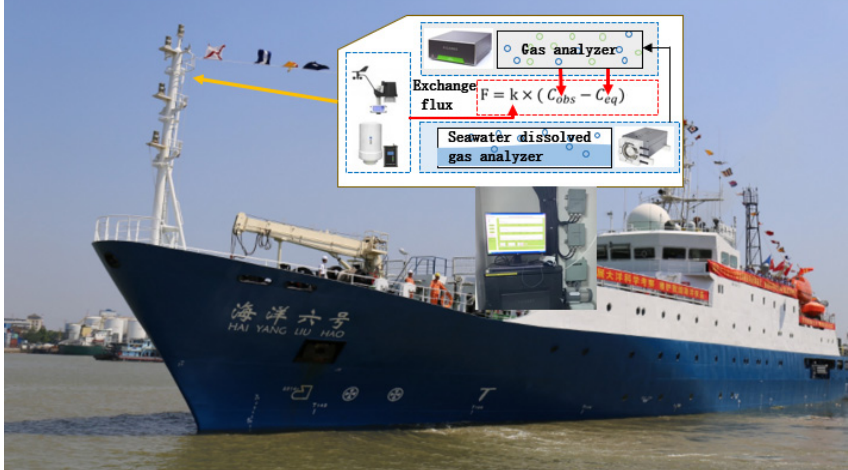
Figure 6. Schematic diagram of the survey ship and air–sea exchange flux measurement system.